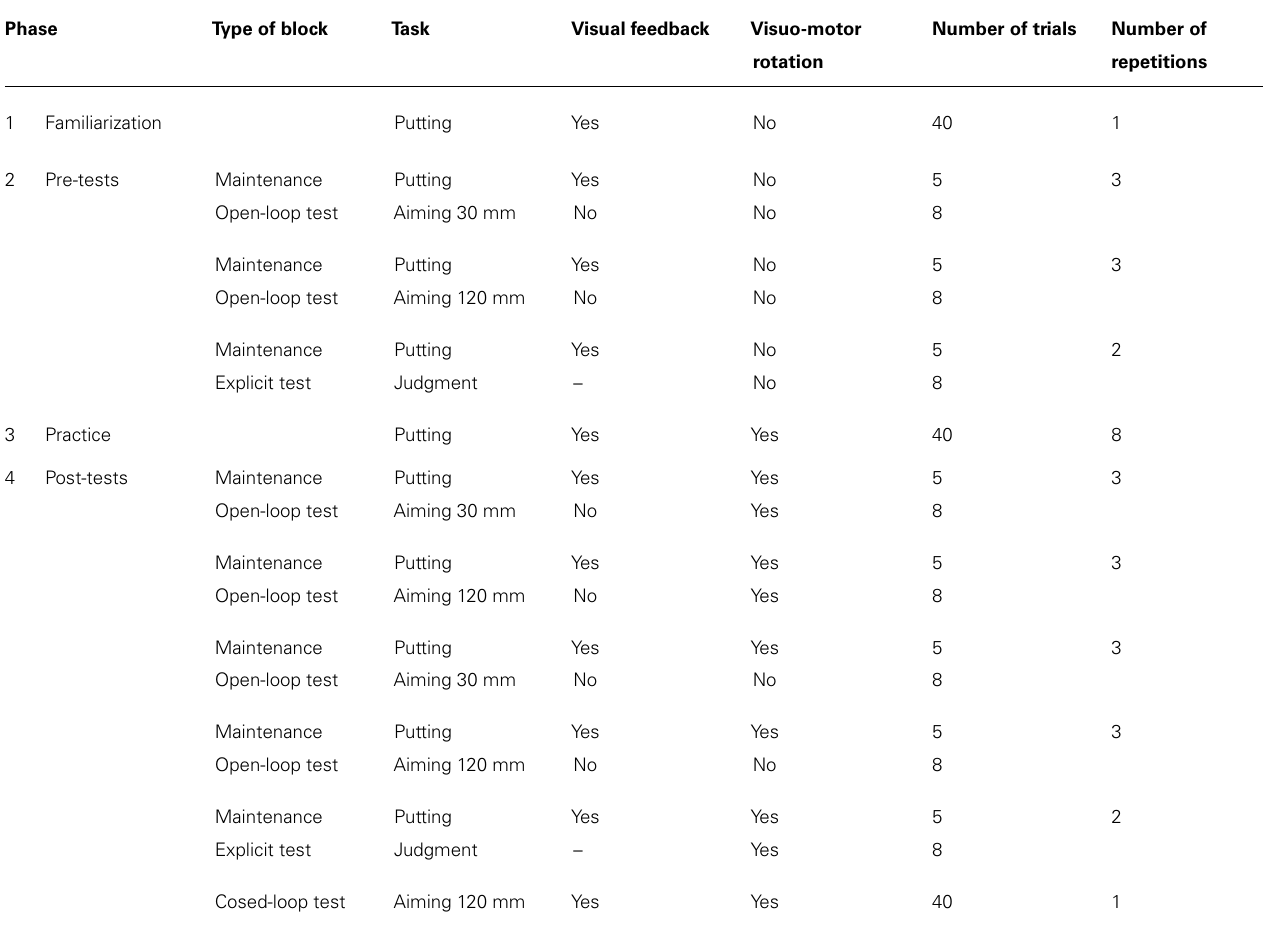
Table 1 | Overview of experimental